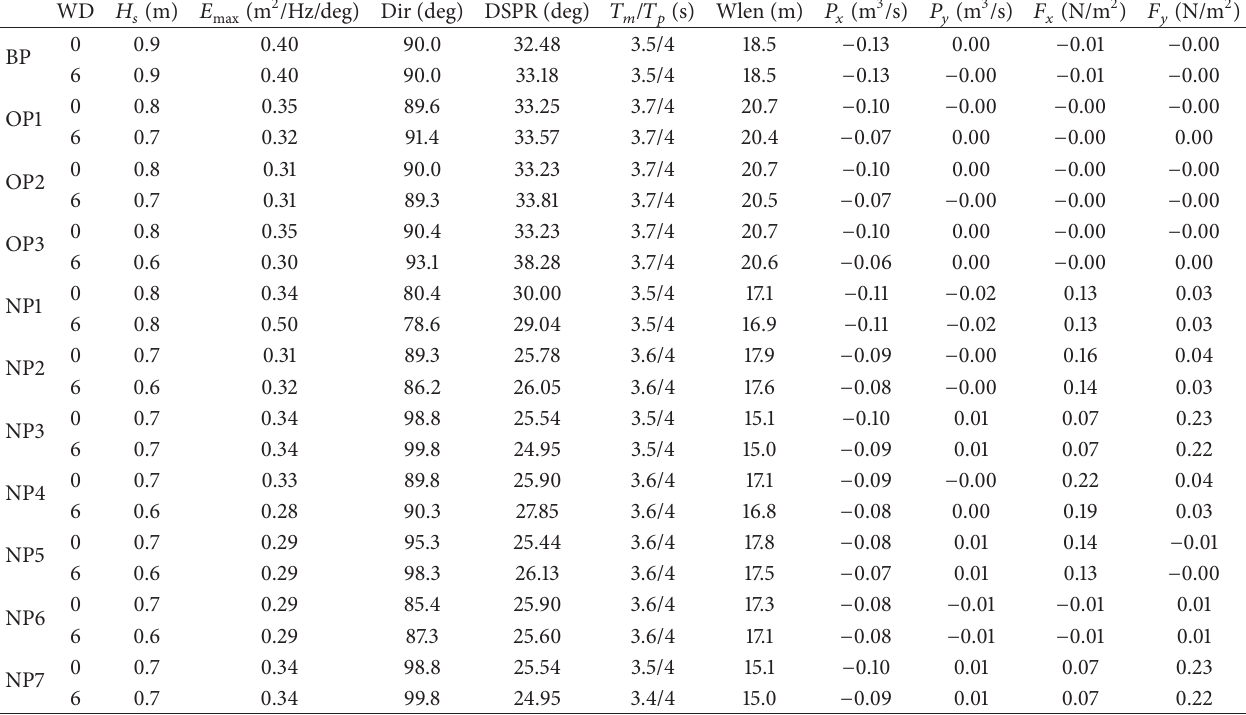
Table 2: CS1 ( 𝐻 𝑠 = 1m, 𝑇 𝑚 = 4s, Dir = 90 ∘ ), evaluation of the impact of the energy farms on the waves in the reference points OP1 (northern offshore point), OP2 (central offshore point), OP3 (southern offshore point), and in the point NP1–NP7. WD0: no energy converter, WD6: four Wave Dragon energy converters operating in line.